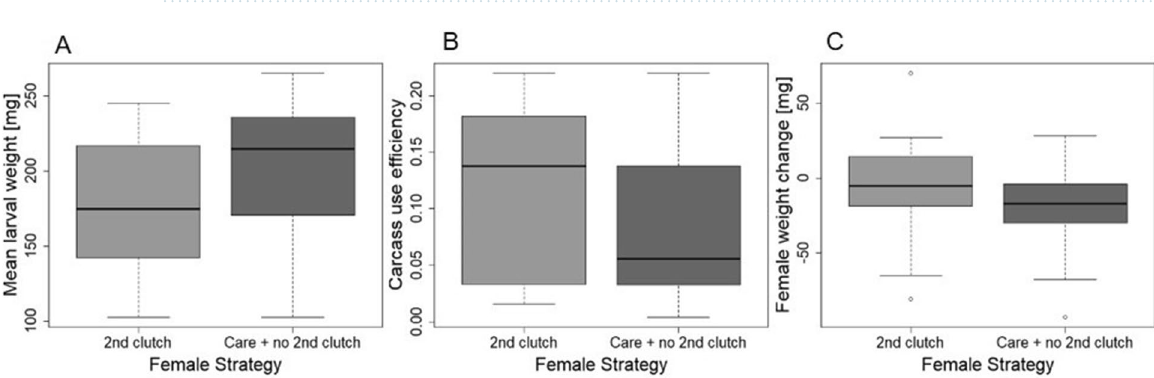
Figure 2. ( A ) Number of dispersed larvae and ( B ) emerging adults of those females that did not produce a second clutch but continued to care for the initial brood and those females that produced a second clutch.